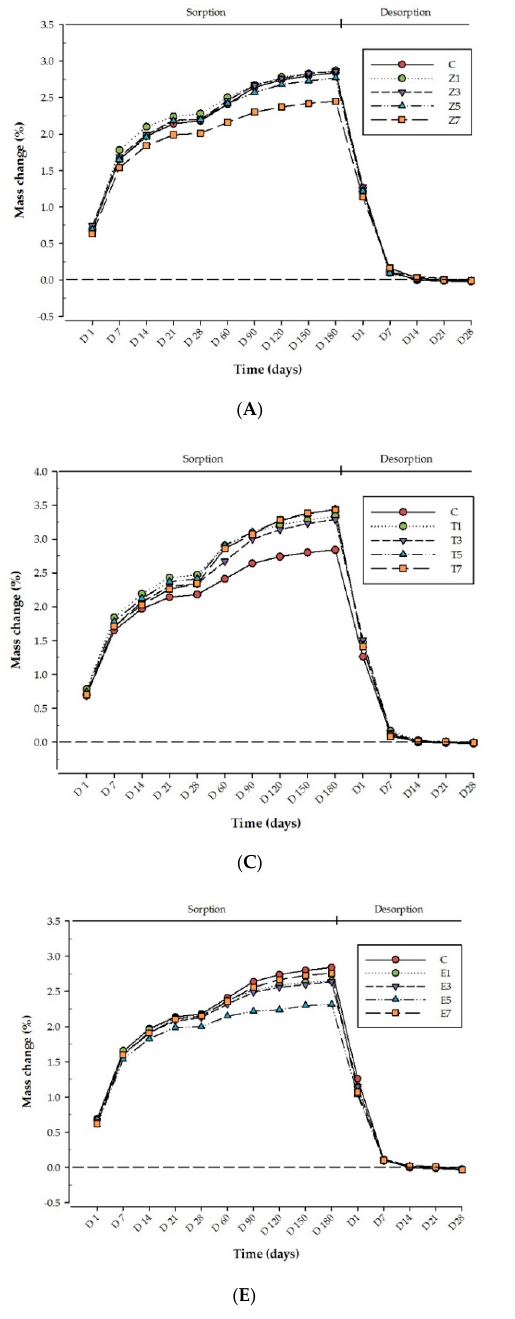
Figure 1. Line graph illustrating the mass change and hygroscopic expansion of each respective tested group with control group ( A ) mass change for Z group, ( B ) volumetric change for Z group, ( C ) mass change for T group, ( D ) volumetric change for T group, ( E ) mass change for E group, ( F ) volumetric change for E group.